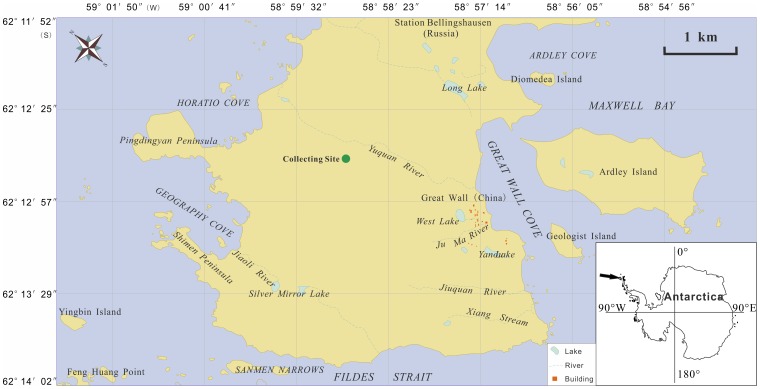
Collecting site of lichen samples in Fildes Peninsula.